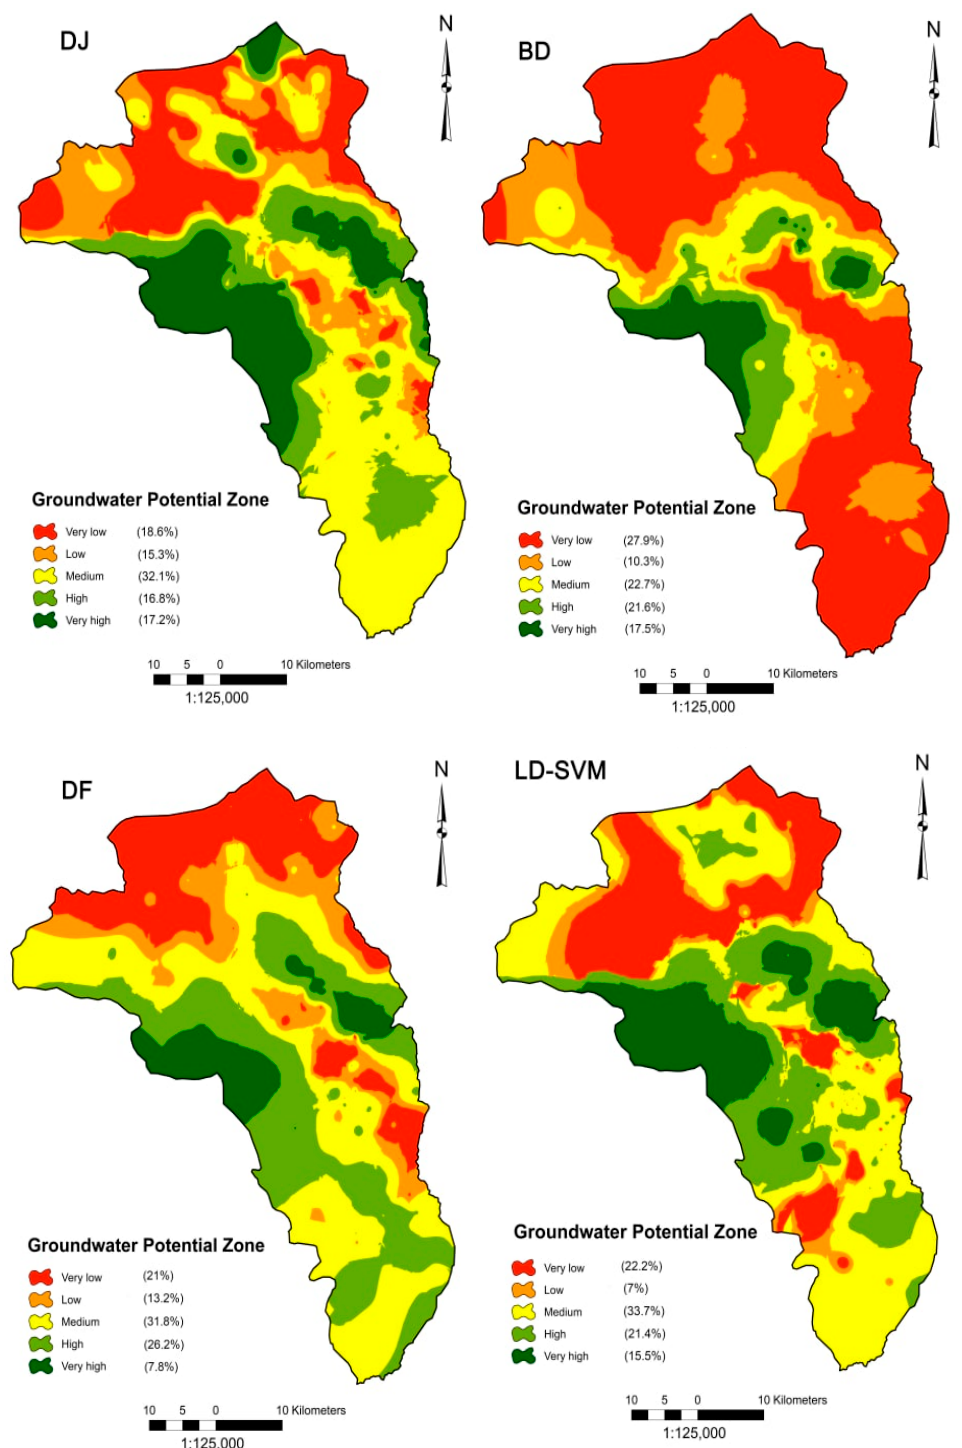
Figure 11. Groundwater potential for the best four models.